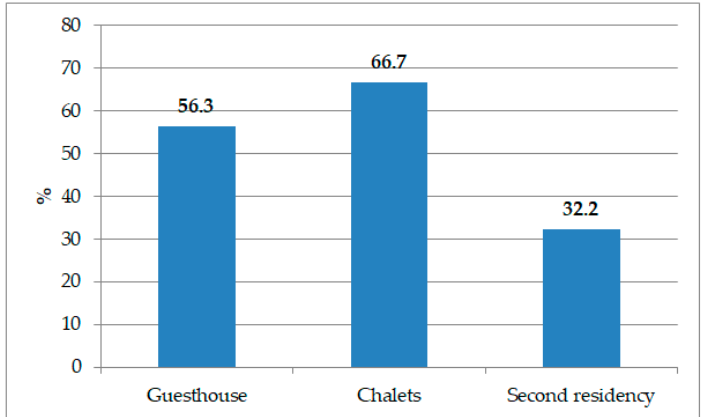
Figure 3. Type of accommodation used during the visit to rural destinations